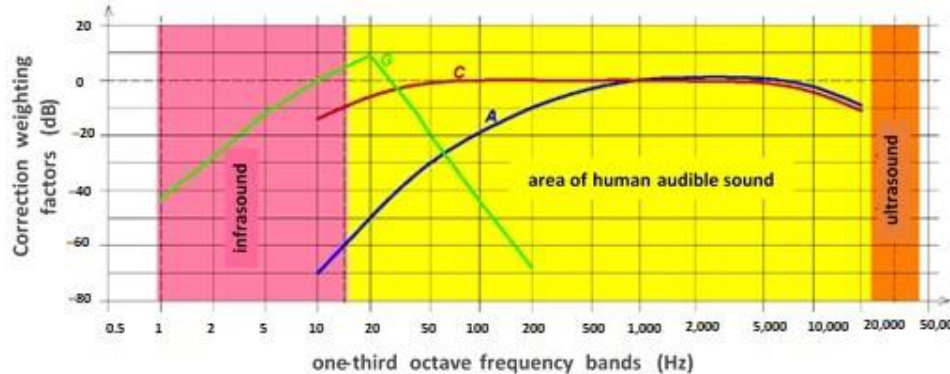
Figure 1. Frequency weighting characteristics for the assessment of human exposure to noise [49].